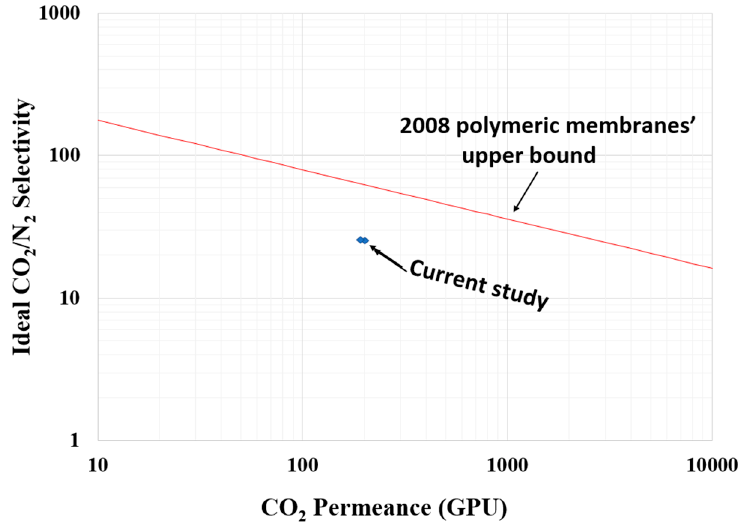
Figure 11. Comparison of study with the upper bound limit. Table 4. Comparison of CO 2 /N 2 selectivity performance with literature data.